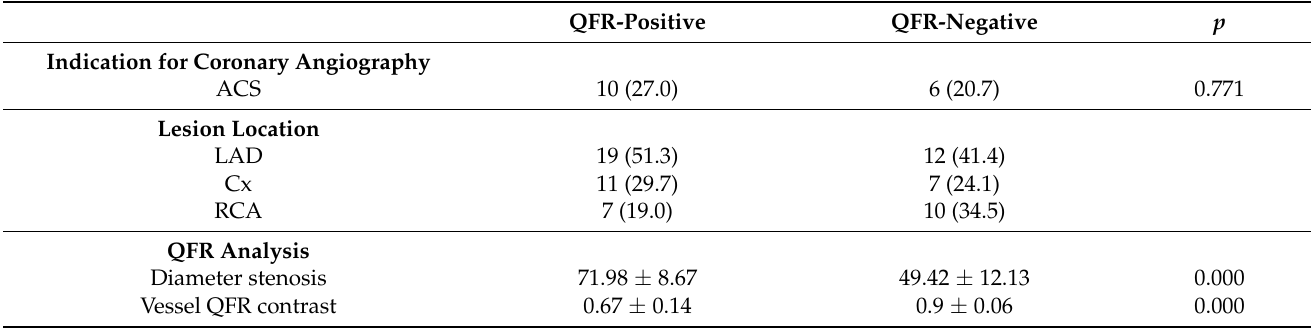
Figure 3. ROC curves of anatomical parameters predicting QFR ≤ 0.8. ( a ) The ROC curve for percent diameter stenosis derived from angiography. Best cut-off 59.5%; ( b ) The ROC curve for MLD derived from IVUS. Best cut-off 1.6 mm; ( c ) The ROC curve for MLA derived from IVUS. Best cut-off 2.4 mm 2 . Table 2. NIRS, IVUS and QFR